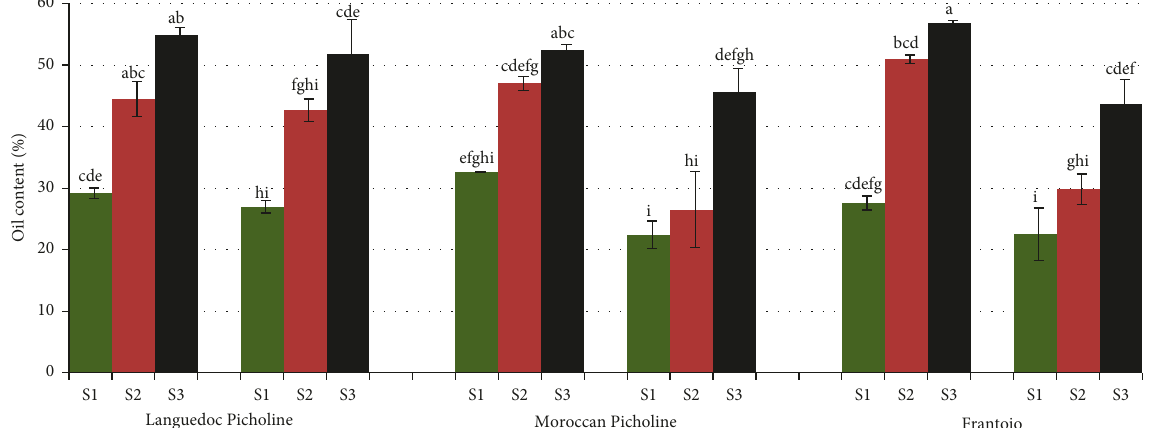
Figure 3: Oil contents (% DW) of different olive cultivars grown in the Errachidia region (East Morocco) at different stages of maturity (S1: green; S2: purple; S3: black). Values are means ± standard deviation (SD) of three replications. Data followed by different letters are significantly different from each other ( P < 0 . 05) according to the LSD test.